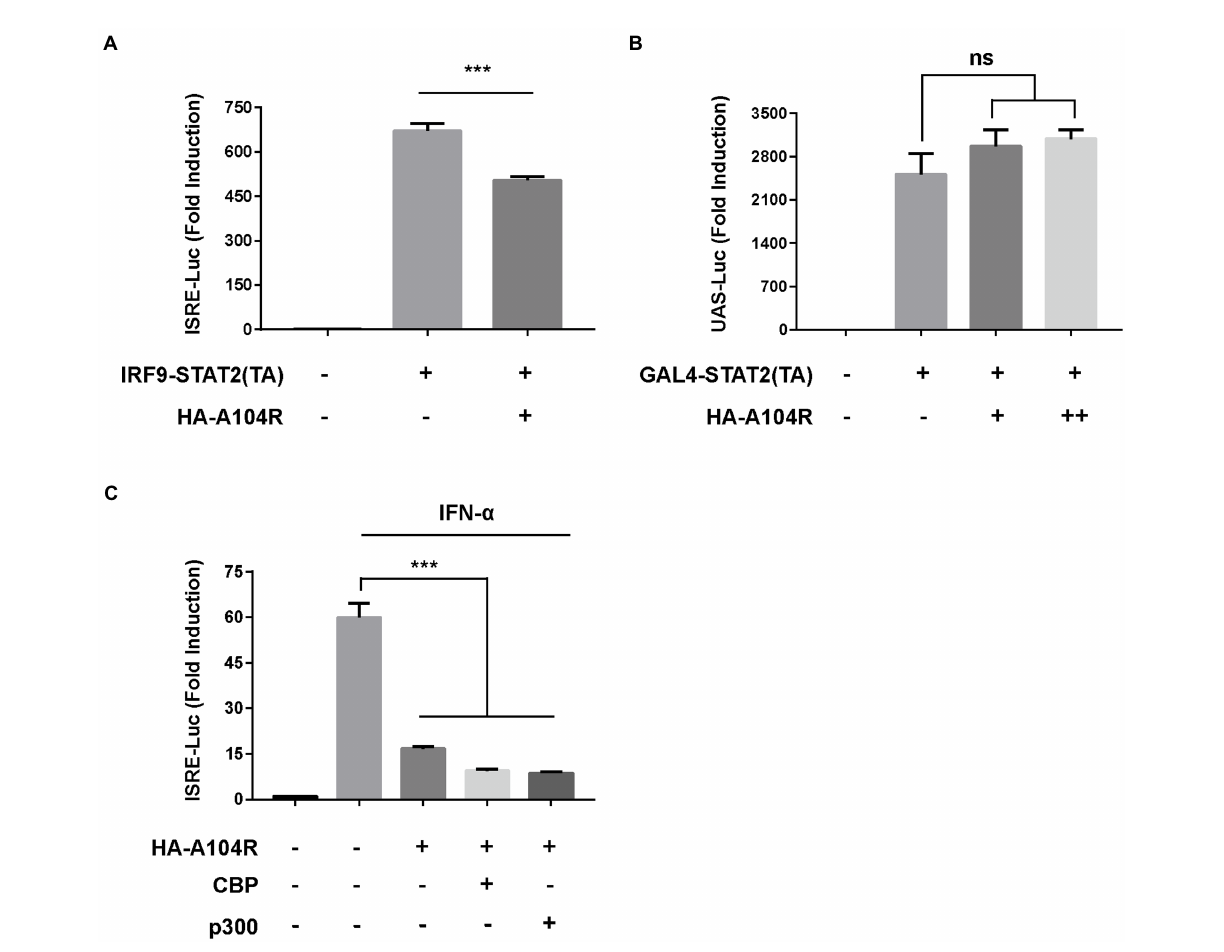
FIGURE 6 ASFV pA104R does not exert repressive effects on trans-activation domains and transcriptional co-stimulatory factors. (A) HEK-293 T cells were co- transfected with pA104R and IRF9-Stat2(TA) (A) or GAL4-Stat2(TA) (B) , along with pRL-TK and pISRE-Luc (A) or pGAL4-UAS-Luc (B) plasmids. After 30 h, a luciferase assay was performed. (C) HEK-293 T Cells were co-transfected with pA104R and CBP or p300 along with pISRE-Luc and pRL-TK plasmids. After 24 h post-transfection, cells were treated with 1,000 U/mL IFN- α for 12 h, followed by luciferase assays. Data are shown as means ± SEM from three independent experiments. Statistical analysis was performed by one-way ANOVA. *** p <